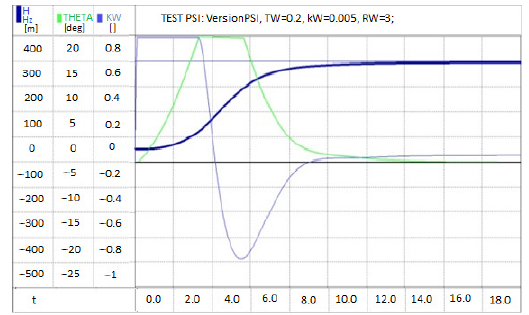
Figure 5. The transitional process of controlling flight altitude ( H ) , with step changes to the given flight value from 50 metres to 400 metres, depending upon the derivative constant of Rw, for k w = 0.005 and R w = 3 [s]